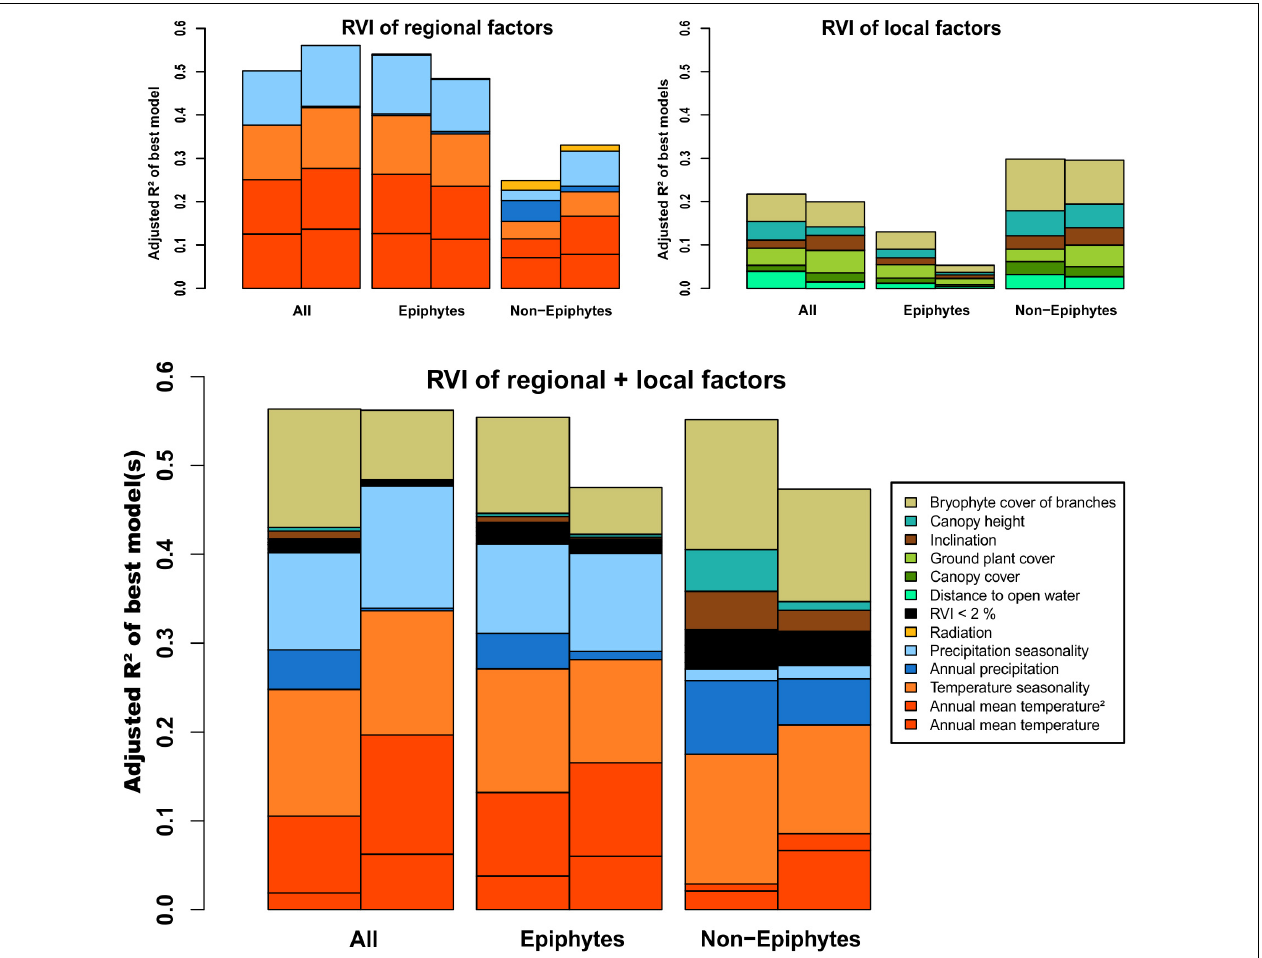
FIGURE 3 | Barplots illustrating relative variable importance (RVI) of regional, local, and regional + local factors, relative to the according goodness of fit criterion (adjusted R 2 ). Left bars show results from plot analyses, right bars from analyses restricted to subplot